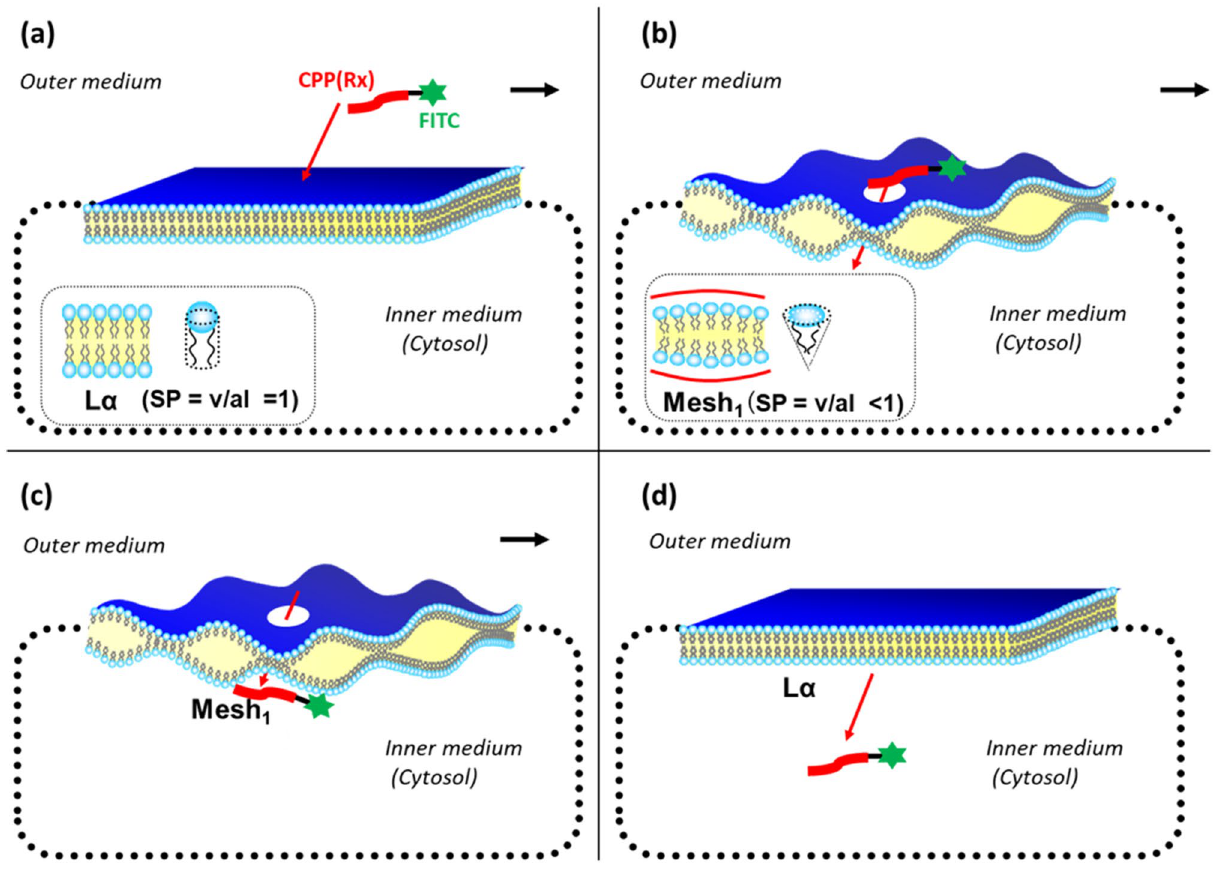
Figure 1. Mechanism of Cytolytic direct internalization (Cytolysis) of Origo-arginine (Rx) as CPP by Temporal and Dynamic phase transition from Lα to Mesh 1 . ( a ) Electrostatic adsorption of CPP molecule, ( b ) generation of positive curvature to induce phase transition to Mesh 1 , ( c ) translocation to the inner side of membrane under Mesh 1 , ( d ) desorption into